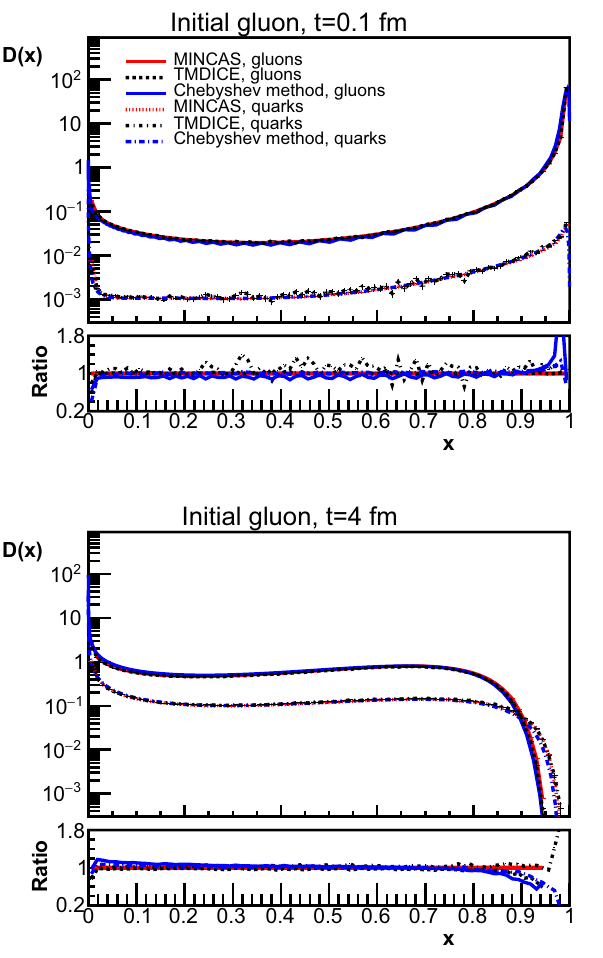
Fig. 14 Comparisons of the x distributions from the Monte Carlo pro- grams MINCAS and TMDICE for the evolution equations (20) with the results from the Chebyshev method for the evolution equations (61) at